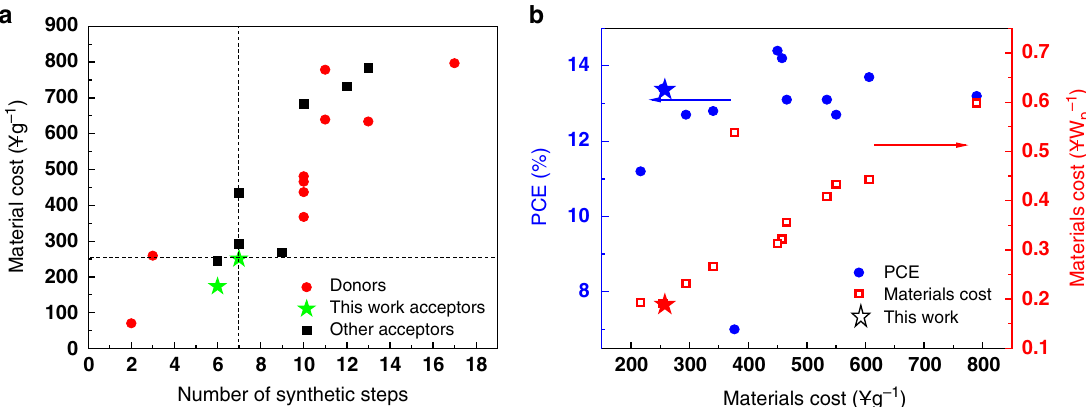
Fig. 5 Cost analysis of the photovoltaic materials. a Plot of the calculated material costs (¥ g − 1 ) versus the number of required synthetic steps for the high performance photovoltaic materials and b plots of PCE or calculated material cost-per-peak-Watt (¥ W p − 1 ) versus the materials cost-per-gram (¥ g − 1